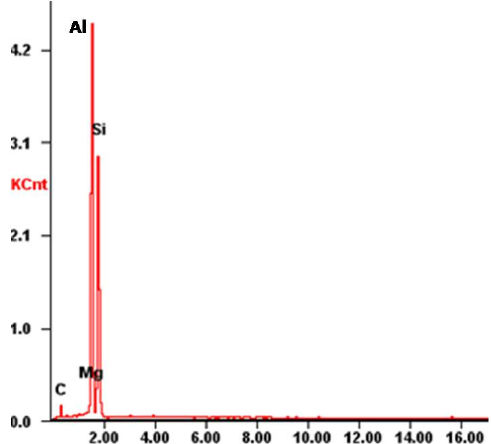
Figure 8. Principal component analysis of eutectic silicon.